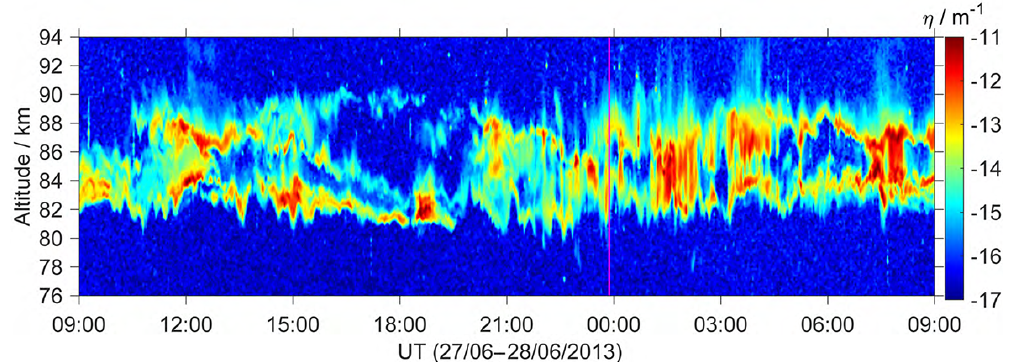
Figure 3. PMSE display observed by the vertical beam of MAARSY in terms of radar reflectivity. The vertical line marks the WADIS-1 launch time, 23:52:30